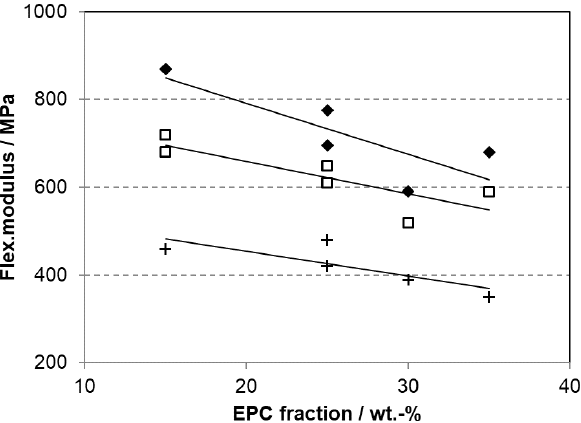
Figure 15. Flexural modulus of random-heterophasic ethylene–propylene copolymers (RAHECOs) with different C2 contents of the matrix ( ♢ 4 wt.%, □ 6 wt.%, + 8 wt.%) and EPC content (C2 of EPC ~36 wt.% C2, data from [107]).